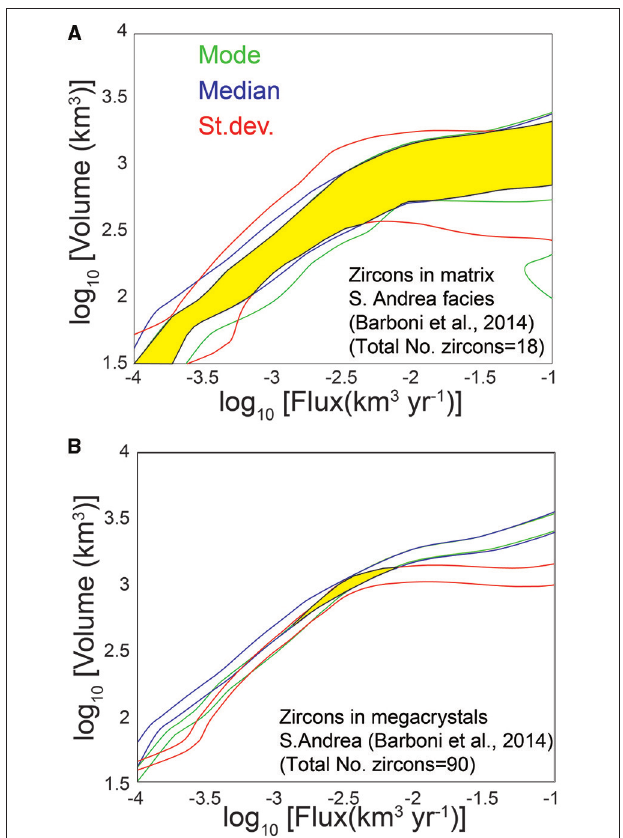
FIGURE 11 | The lines represent the 95% confidence interval for mode, median, and standard deviation obtained by bootstrapping the populations of zircon crystallization times presented in Figure 10 (A,B), respectively. The colored areas provide the estimated volume and magma flux obtained applying the method presented in this contribution. Estimates were obtained by considering a zircon crystallization between 700 and 750 ◦ C. Using different zircon crystallization ranges would not change significantly the final estimates as contours in Figure 6 for different T zr are very